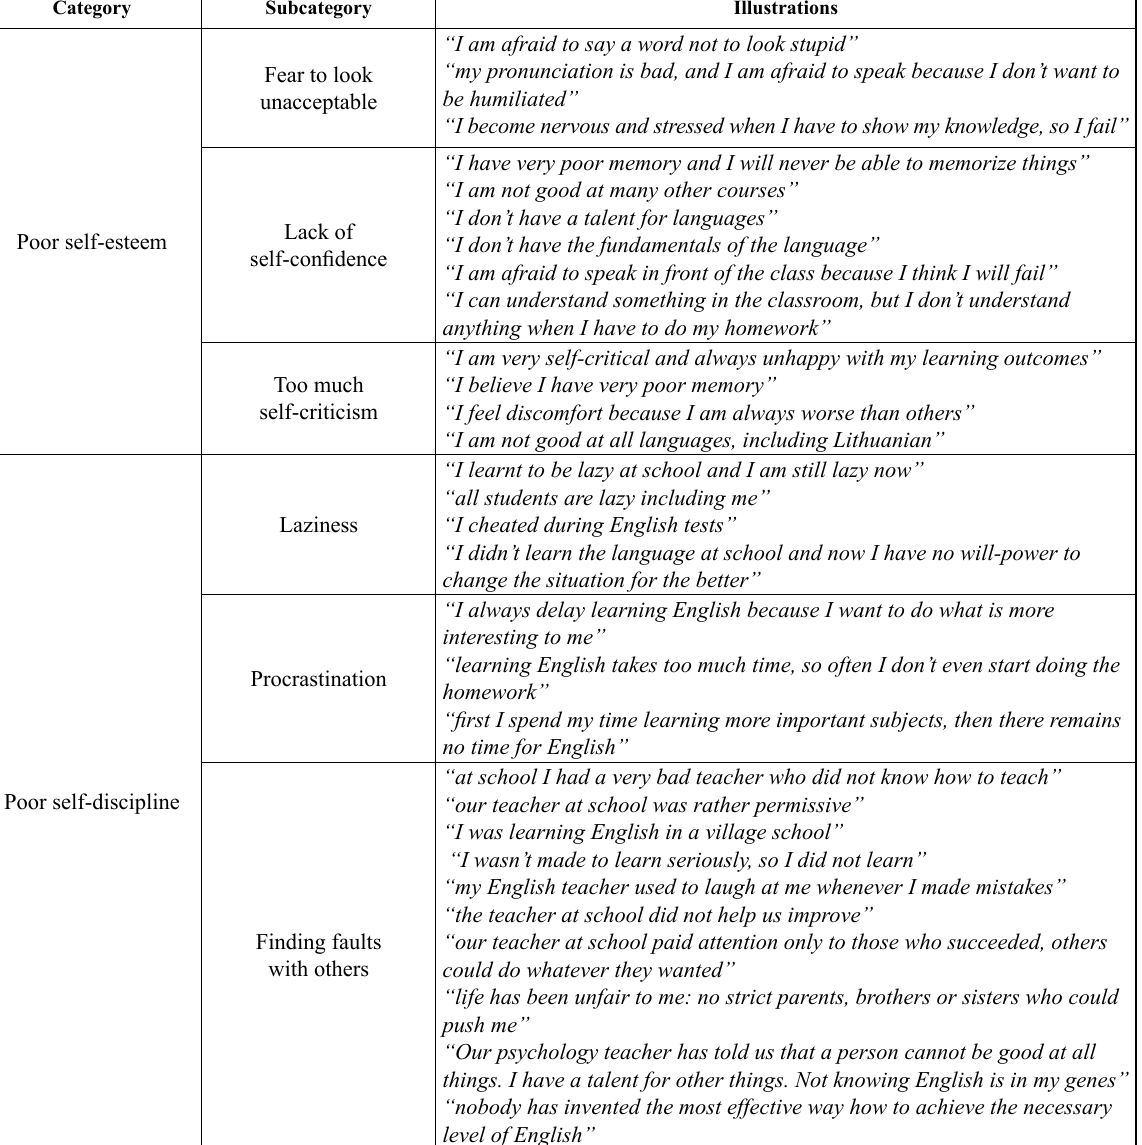
Table 1. Internal causes of underachievement in English